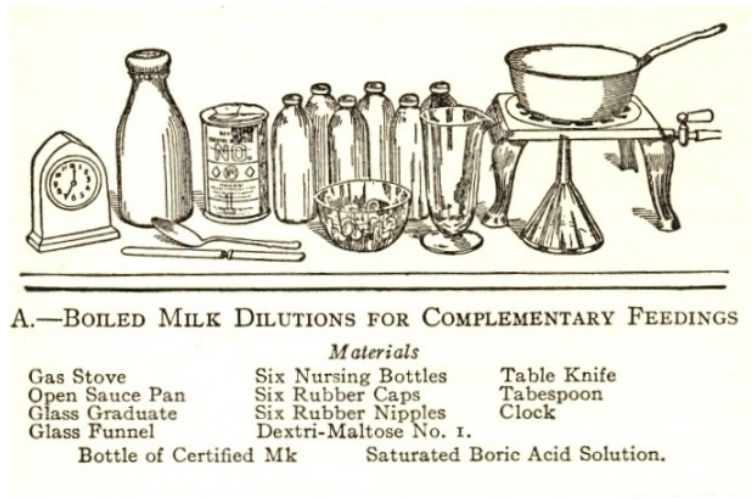
Figure 5. How to Make Baby Formula.